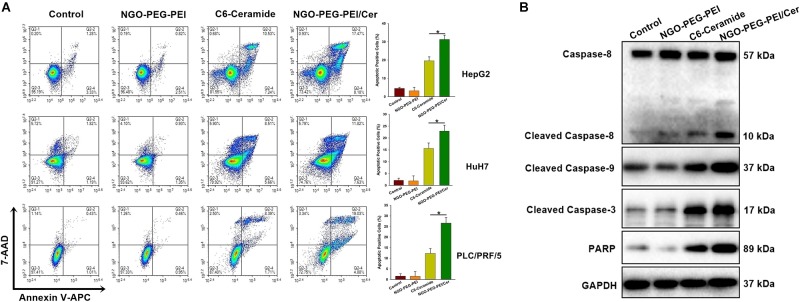
NGO-PEG-PEI/CER induced apoptosis in HCC cells in vitro. (A) Apoptosis was analyzed via Annexin V-FITC/PI double staining. HepG2, HuH7, or PLC/PRF/5 cells were infected with NGO-PEG-PEI/Cer (10 μM), C6-ceramide (10 μM), or NGO-PEG-PEI (100 μg/ml) for 24 h. Florescence was then analyzed by flow cytometry. Data are presented as mean ± SD of three separate experiments. (B) HepG2 cells were infected with NGO-PEG-PEI/Cer (10 μM), C6-ceramide (10 μM), or NGO-PEG-PEI (100 μg/ml) for 24 h. Whole cell extracts were prepared and immunoblotted to detect caspase pathway activation. GAPDH was used as a loading control. ∗P < 0.05.